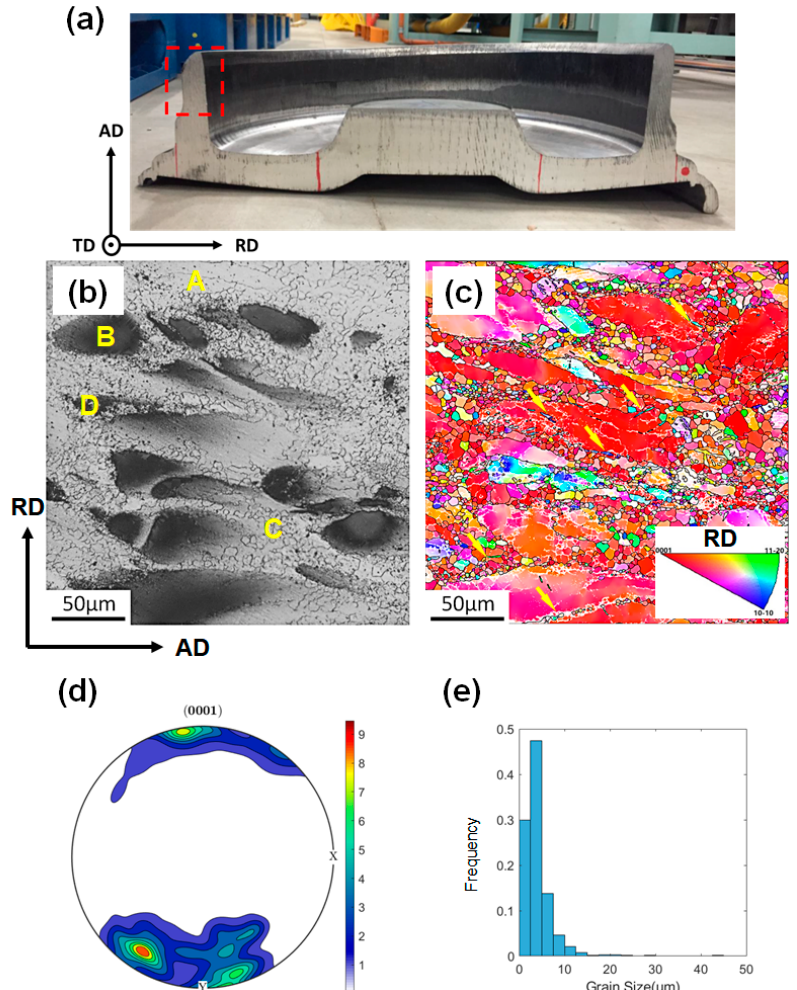
Figure 1. Initial microstructure of the as-received sample: ( a ) location of sampling for hot compression, ( b, c ) corresponding optical microscope (OM) and electron back-scattered diffraction (EBSD) micrographs of ( a ), ( d ) corresponding (0001) pole figure, and ( e ) grain size distribution calculated from the EBSD dataset of ( c ). The step size for EBSD measurements was 0.3 μ m.